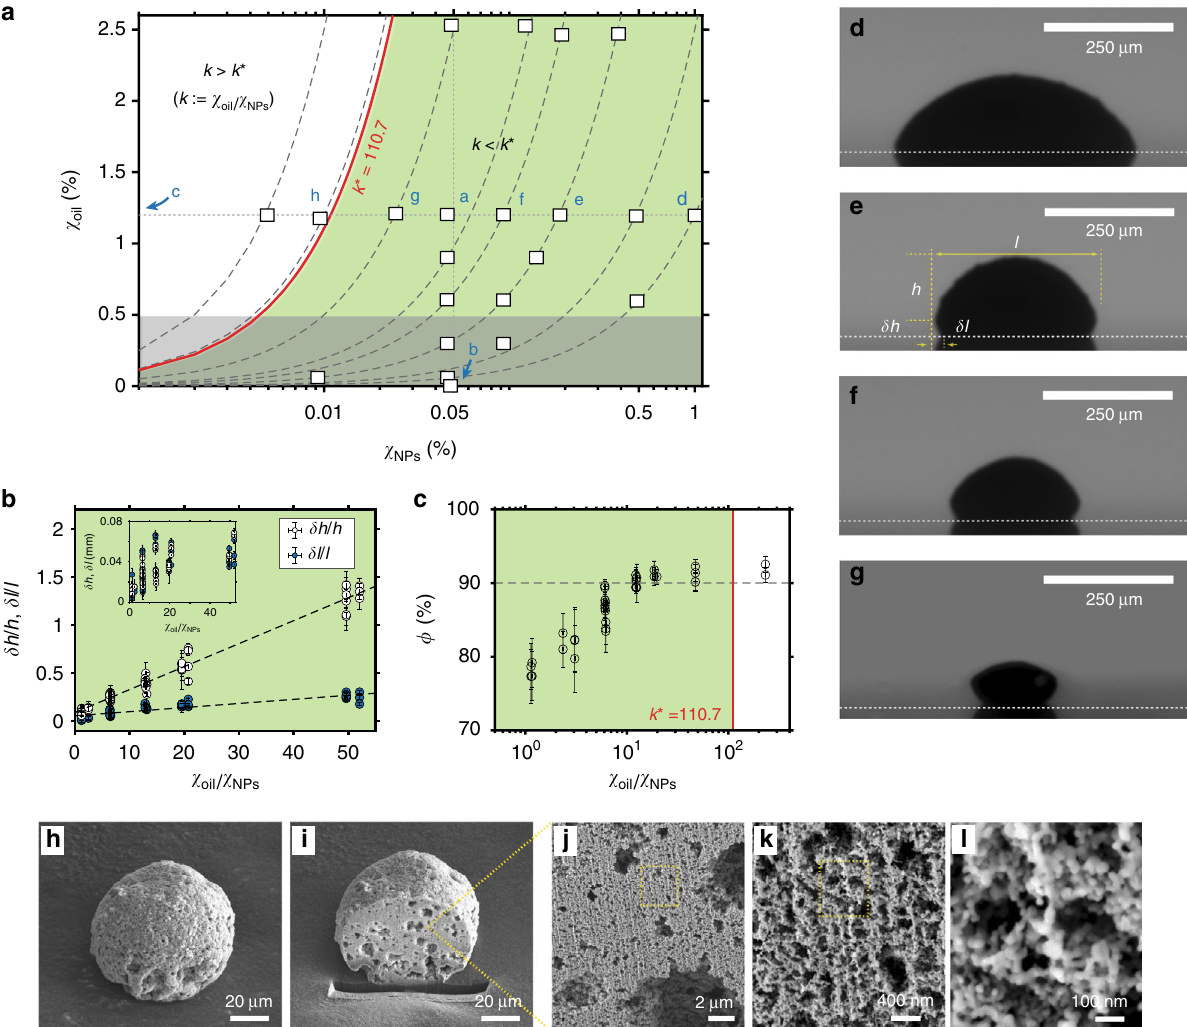
Fig. 3 Supraparticles with tunable shapes and high porosity. a Parameter space showing the initial oil volume fraction χ oil and nanoparticles volume fraction χ NP of colloidal drops in different cases (white square dots) with a same ethanol-to-water ratio (3:2). The calculated critical oil-to-nanoparticle ratio, 110.7 (solid red line), divides the space into high ( k > k * ) and low ( k < k * ) oil-to-nanoparticle ratio regions. The generated supraparticles have a ball-like shape in the white region ( k > k * ), while a more fl at, oblate shape (see below) in the green region ( k < k * ). b Both the dimensionless height δ h and depth δ l of the dented part of non-ball-like supraparticles are proportional to the oil-to-nanoparticle ratio in the green region. c The calculated porosity ϕ of supraparticles ranges from 78 to 92%. On increase of the oil-to-nanoparticle ratio, the diverse shapes are from a spherical-cap shape (pro fi le photograph d ), to a mushroom-like one e , f , and to a cupcake-like one g . Above the critical ratio k * , a ball-like supraparticle is achievable (SEM image h ). i Cross-section of the same supraparticle in h obtained by a FIB cutting illustrates the highly porous structure inside (Supplementary Movie 4). j – l A sequence of 3 zooms into the inner structure. The horizontal white dotted lines in d – g indicate the substrate position. The shadows below the lines are re fl ections. The image e shows the de fi nitions of δ l , l , δ h , h . The error bars of the dimension and porosity of supraparticles represent the uncertainty in image processing. The error bars of the volume fraction of oil and nanoparticles represent the uncertainty from the preparation of the solution. The temperature and relative humidity during experiments were 20 – 23 °C and 35 – 50%,